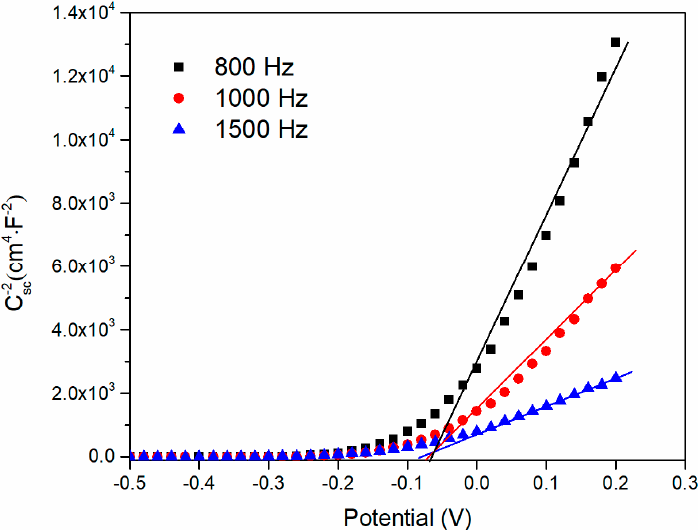
Figure 3. Mott–Schottky plot of the hematite electrode measured at 0.8, 1.0, 1.5 kHz under dark conditions.